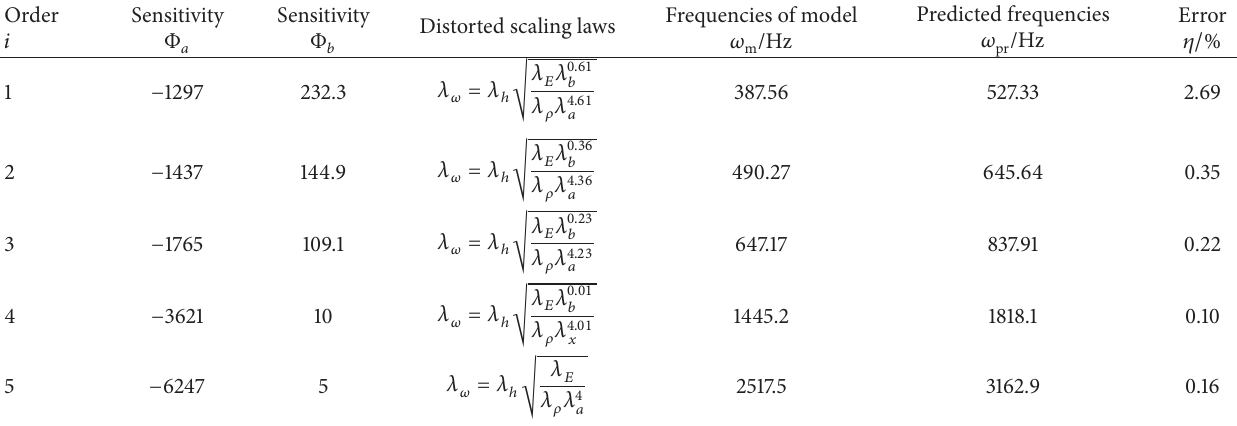
Table 5: The distorted scaling laws.